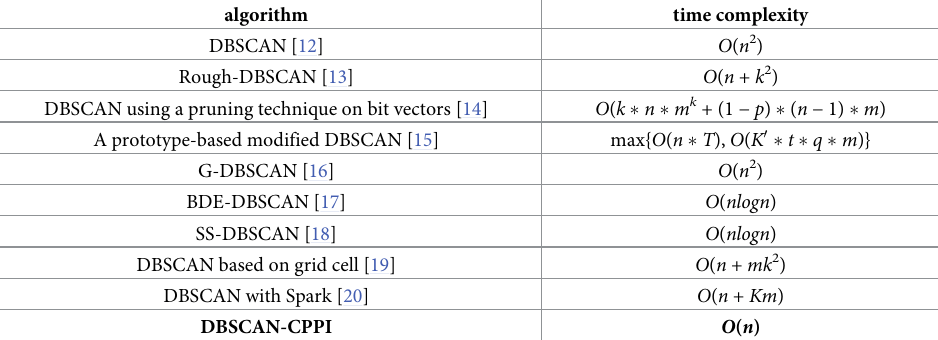
Table 2. Comparisons results of time complexity of some proposed DBSCAN algorithms.